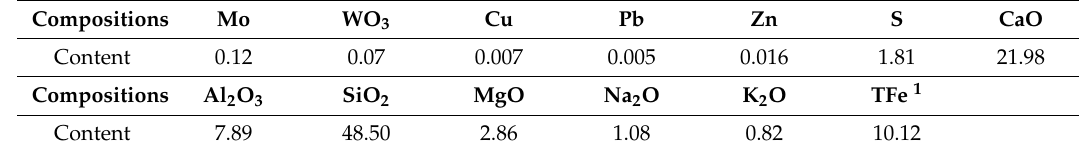
Table 1. The elemental composition of the actual Mo ore (wt %).